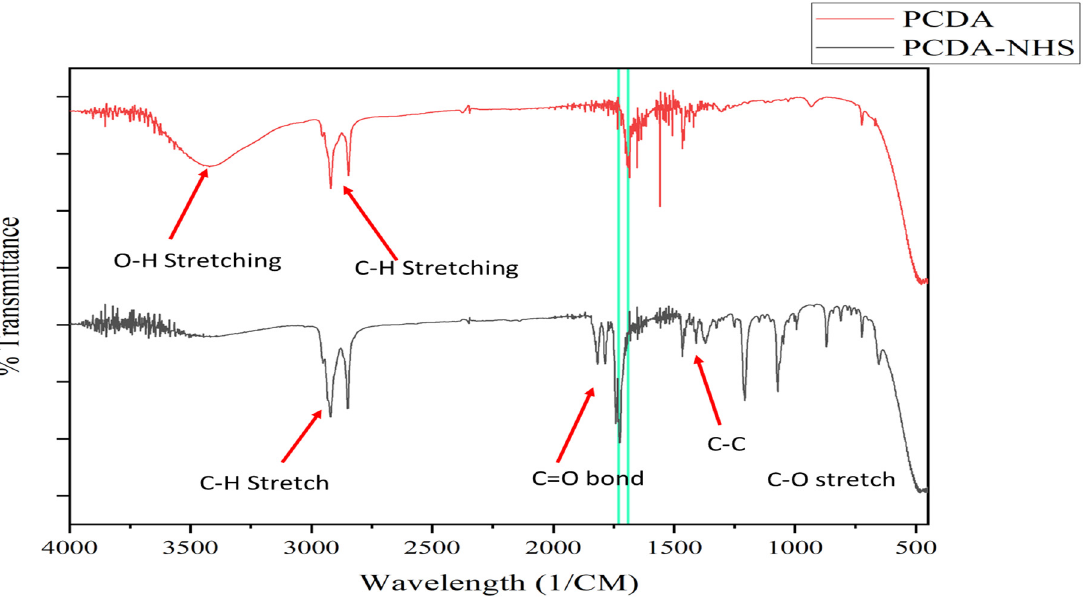
Figure 2. FT-IR spectra of PCDA and PCDA-NHS. FT-IR spectra were obtained from 3 mg of PCDA and 3 mg of PCDA-NHS separately dissolved in ethyl acetate. The peak in the PCDA spectra at 1690 cm − 1 results from carboxylic acid stretching, which is not present in the spectra for PCDA-NHS. The peak in the PCDA-NHS spectra at 1729 cm − 1 results from the NHS ester bond, which is not present in the spectra for PCDA. Two vertical lines are displayed to emphasize these peaks.